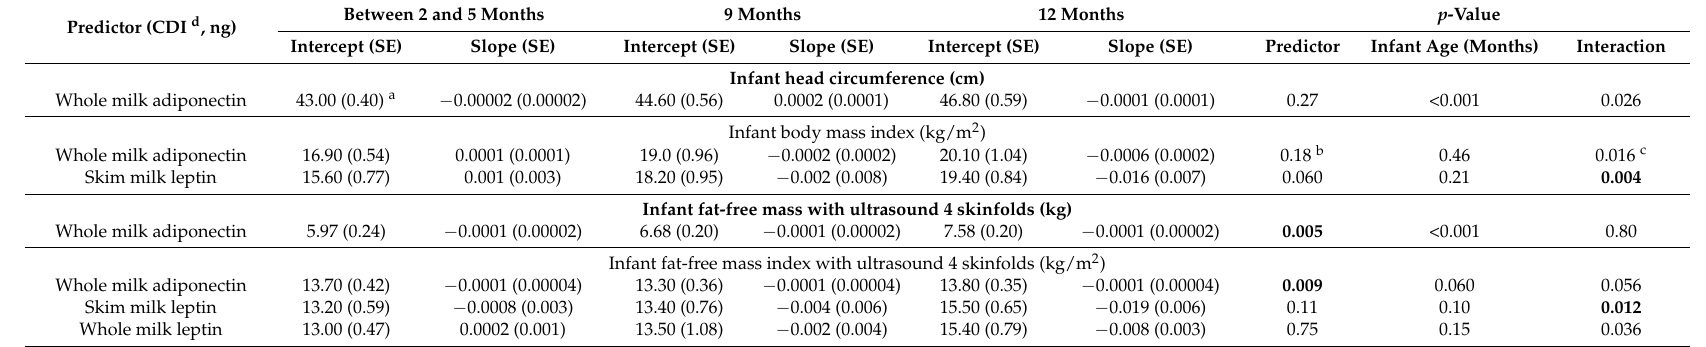
Table A3. Associations between calculated daily intakes of human milk adipokines and infant